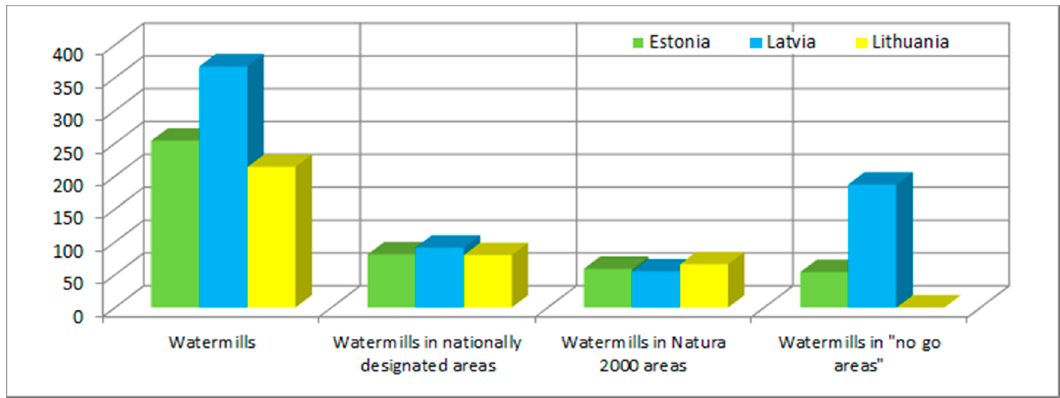
Figure 10. The number of watermill sites located in environmentally sensitive areas in the Baltic